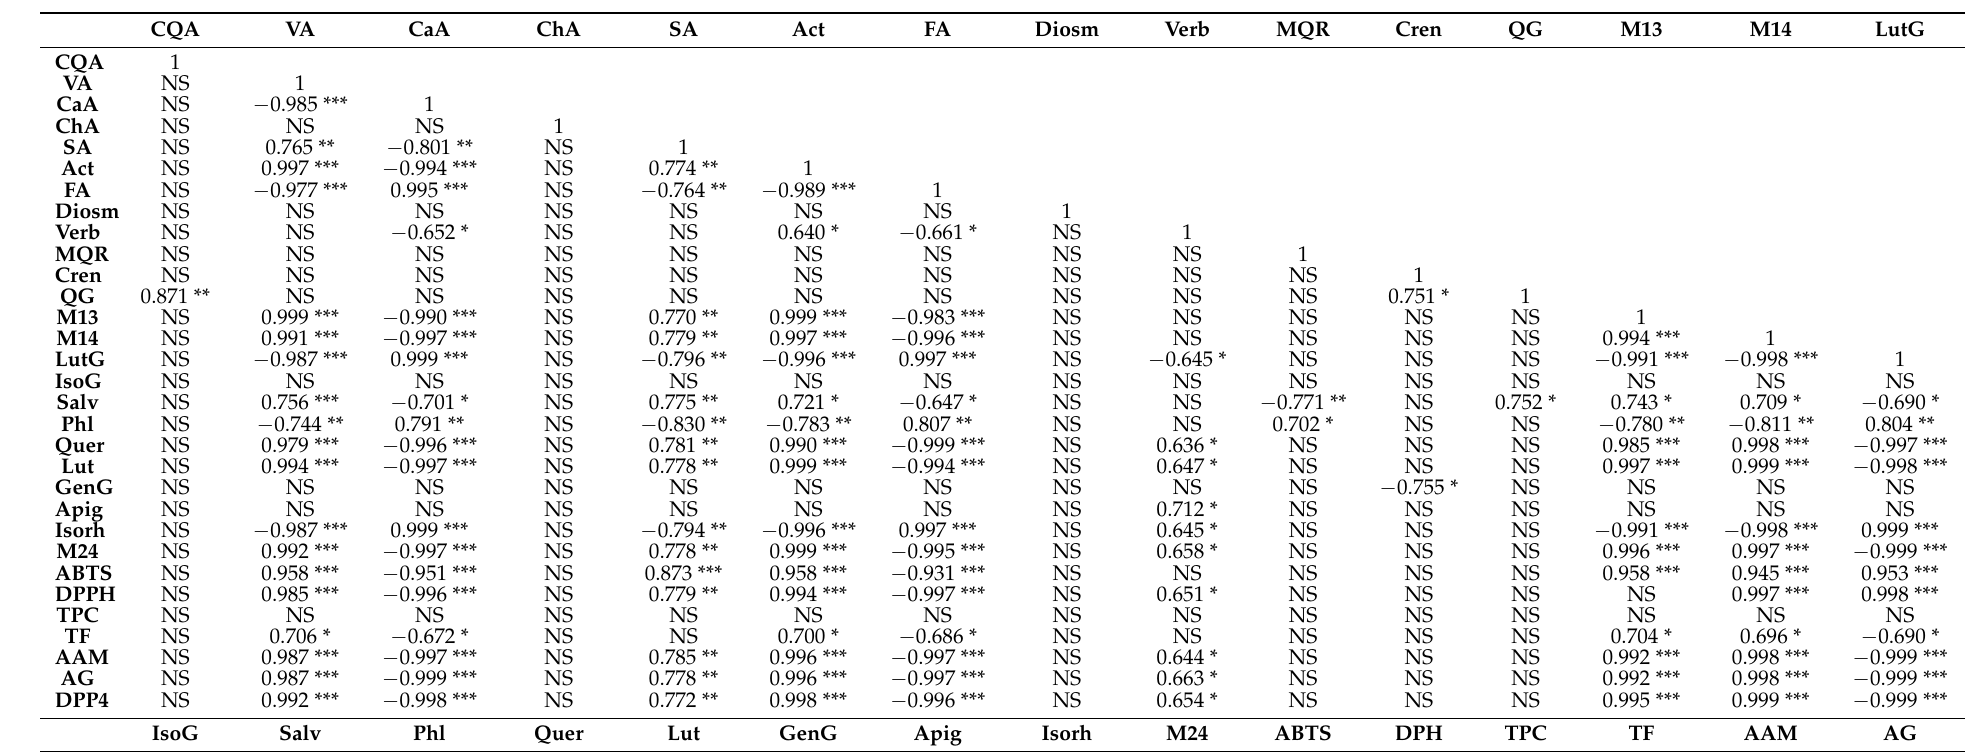
Table 4. Correlation of metabolites and